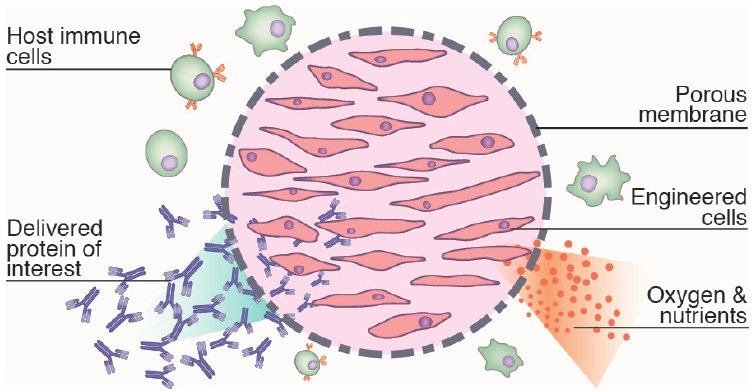
Figure 1. Overall concept of encapsulated cell